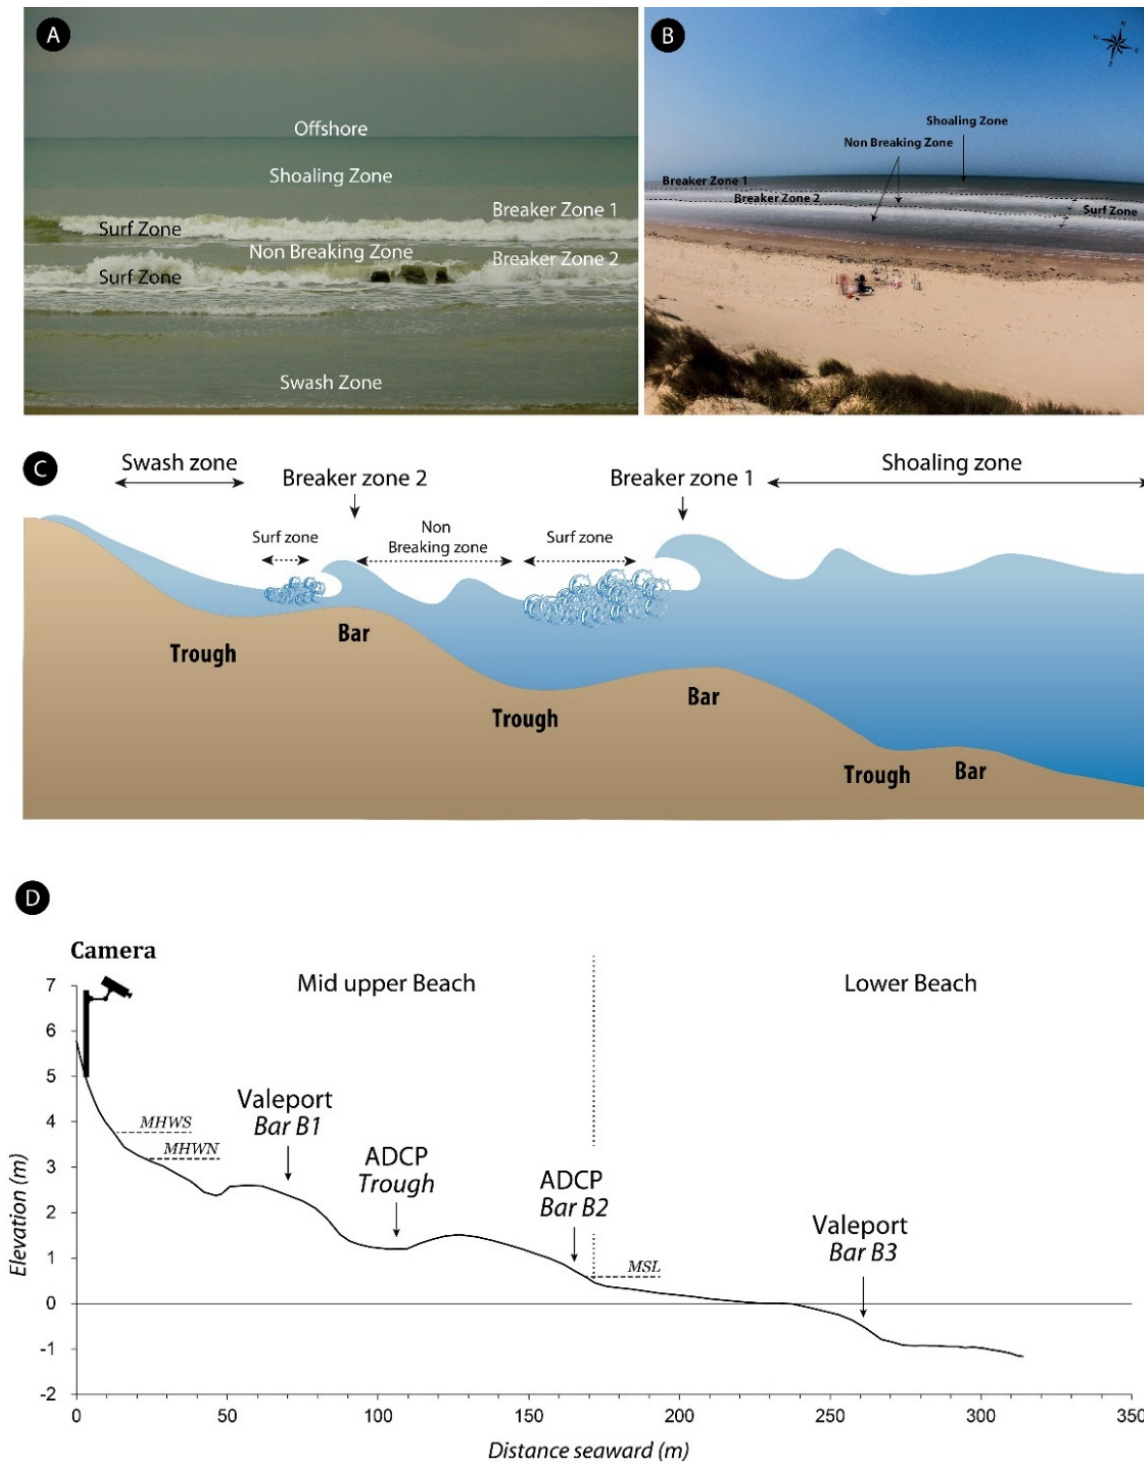
Figure 2. ( A ) Photograph of multiple breaker and surf zones due to wave reformation on the studied beach; ( B ) example of an averaged image of 60 consecutive photographs showing the location of breaker zones and non-breaking zones; ( C ) schematic representation of the different hydrodynamic zones distinguished during the field experiment; ( D ) cross-shore profile showing the location of the video camera and hydrodynamic instruments deployed in the intertidal zone (elevations are relative to the French topographic chart datum). Altitudes of mean sea level (MSL) and of mean high-water neap (MHWN) and mean high water spring (MHWS) are indicated on the lower